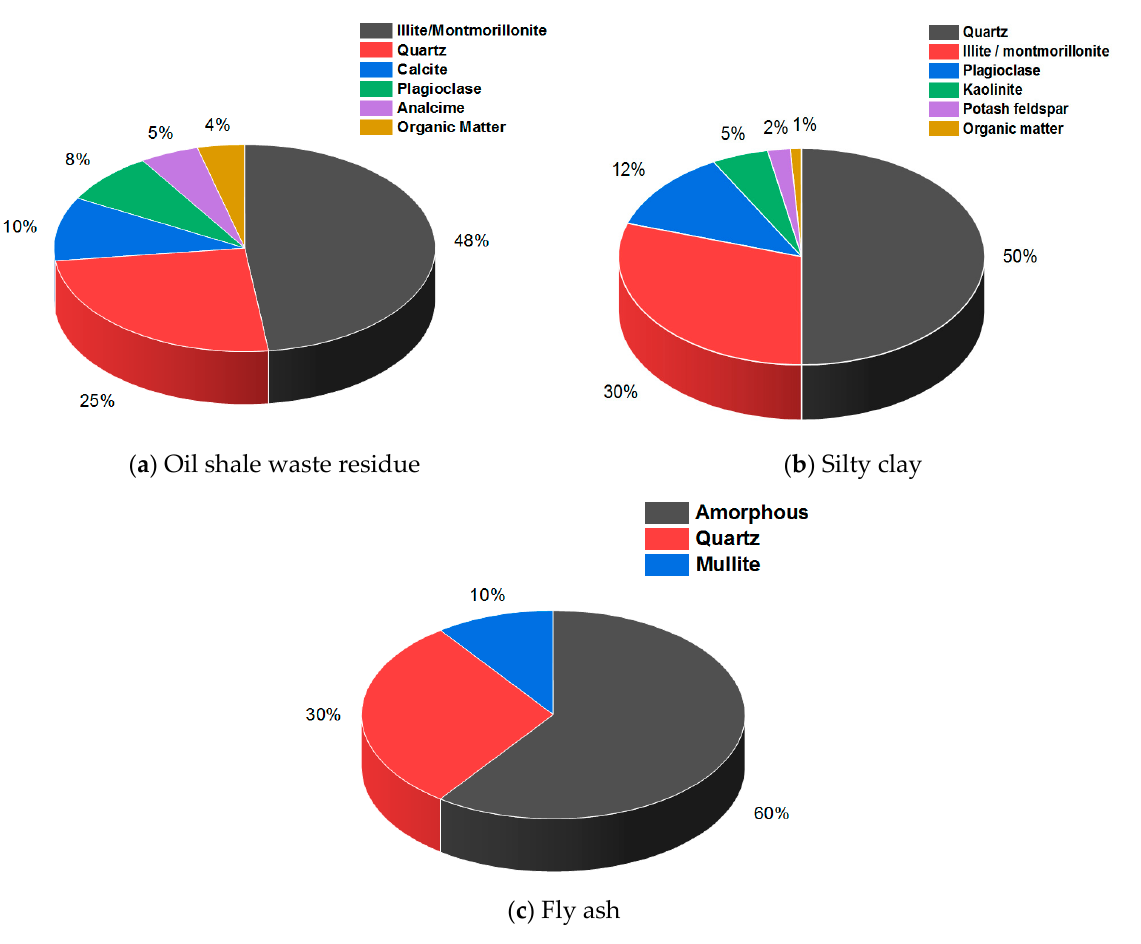
Figure 1. The mineral composition of the three raw materials. Table 2. Chemical composition of the three raw materials.